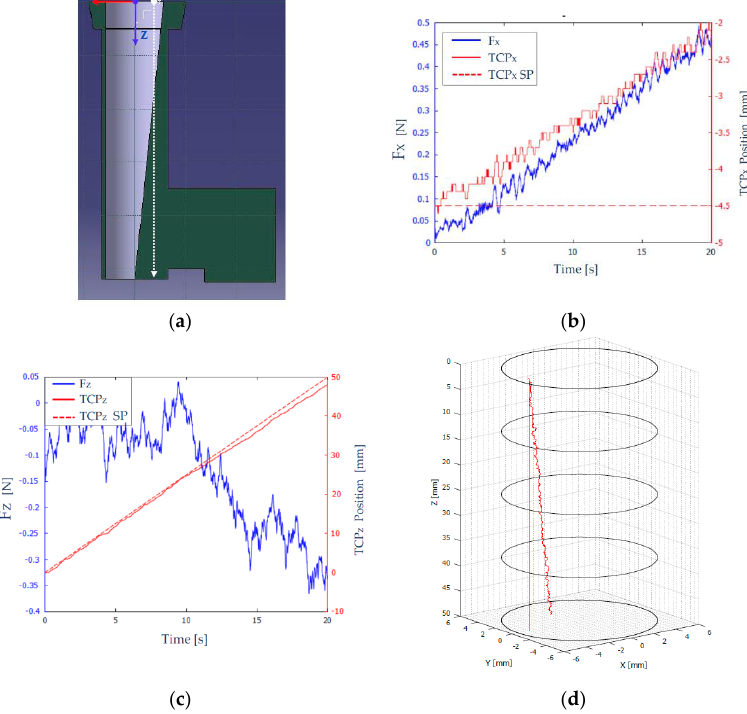
Figure 8. Results obtained in scenario 1. ( a ) Scenario 1 section. ( b ) Forces (blue) and position (red) on the X axis of the robot’s TCP. ( c ) Forces (blue) and position (red) on the Z axis of the robot’s TCP. ( d ) 3D representation of the robot’s TCP position.